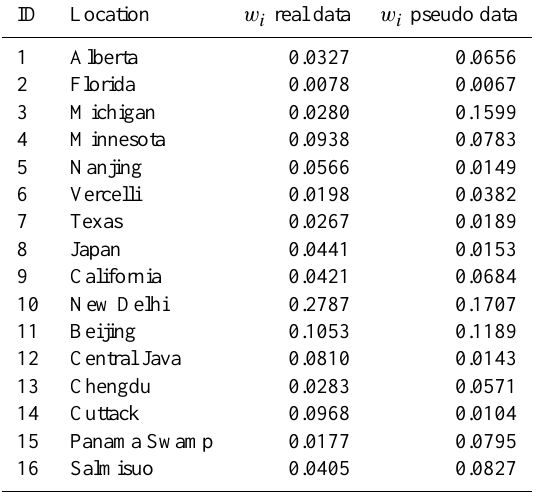
Table D1. ID, name of observation sites, and associated weights for real data and pseudo data case (Eq. 1 of the main